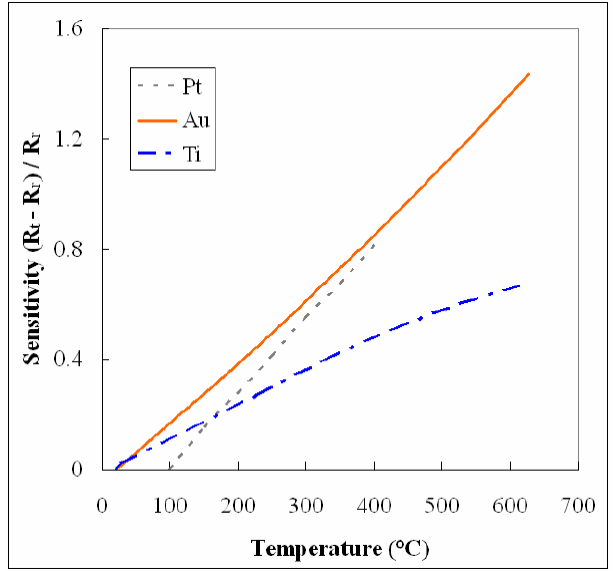
Figure 2. The linearity comparison of sensing materials [19,20].